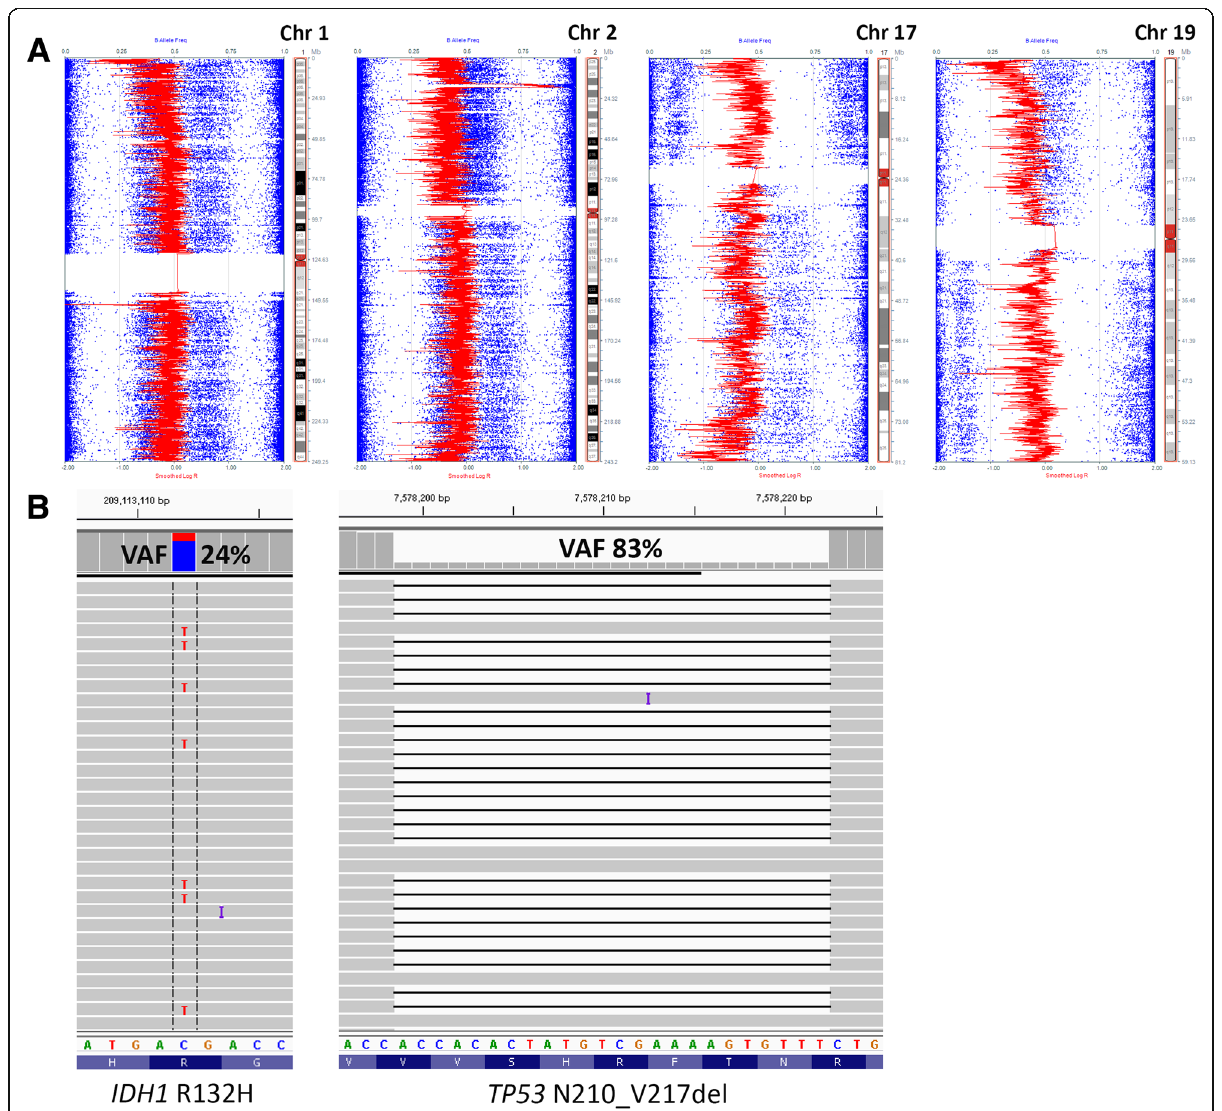
Fig. 3 Single nucleotide polymorphism (SNP) array data using Illumina HumanCytoSNP-850K (v1.1) BeadChip platform (approximately 850,000 SNPs) and iScan microarray system and illustrated with KaryoStudio v2.0 software; red data show smoothed signal intensity values (LRR) (Log base 2 ratio of observed and expected intensities; LogR 0, copy number two) and blue data points represent the B-allele frequency (BAF) of each individual SNP (B-allele frequency of 0 equals no B-allele; 1 equals only B-alleles present). Loss of chromosomal segments is supported by the downward shift of the red vertical line (decrease in LRR, left shift) and loss of heterozygosity (LOH) in BAF (loss of heterozygous BAF track around 0.5 with variable redistribution of BAF in in region of LOH associated with the ratio of tumor to normal DNA in the sample), while gains/amplifications of genomic regions show upward shifts of the red vertical line (increase in LRR, right shift) and LOH in BAF. Loss of whole chromosome 1, 2q, 17p, and the majority of 17q and 19q is depicted here ( a ) as well as gain/amplification of 2p24.2-p24.3, which includes MYCN . Initial amplicon-based targeted next generation sequencing using the Ion AmpliSeq Cancer Hotspot Panel v2 demonstrated an IDH1 hotspot mutation (p.R132H) and an in-frame TP53 deletion (p.N210_V217del), visualized here using Integrated Genomics Viewer v2.3.4 (IGV; Broad Institute, MIT Harvard) ( b ). Subsequent SNP array analysis demonstrated loss of whole arm 17p ( TP53 is located at 17p13.1) in the vast majority of the sample; therefore, the TP53 VAF can be used to approximate tumor purity. The IDH1 mutation, on the other hand, appears to be present in only a fraction of tumor cells, while IDH1 wild type cells comprise the remainder of the tumor with apparent loss of the mutant IDH1 allele ( IDH1 is located at 2q34). Matched normal (tissue or peripheral blood) was not available for